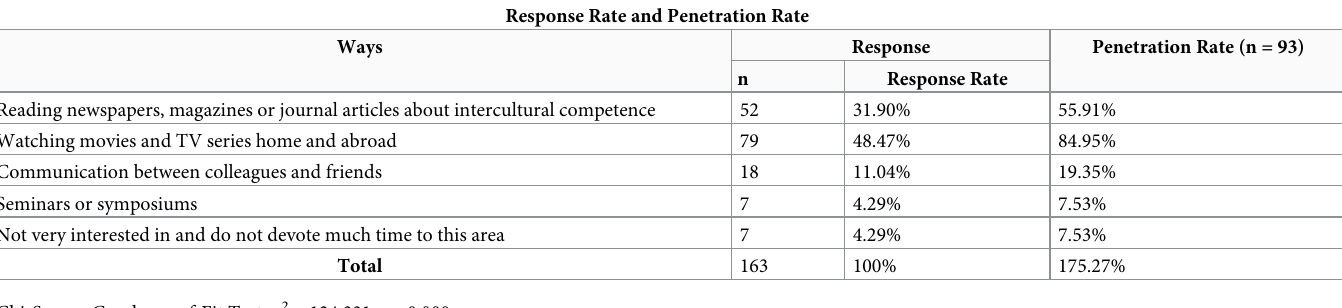
Table 5. Teachers’ main ways in acquiring intercultural